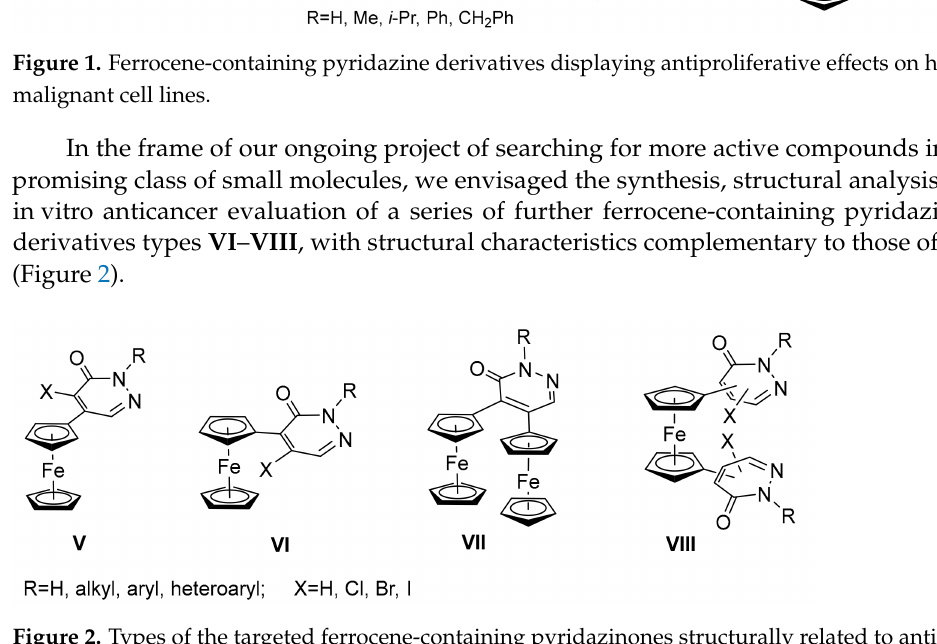
Figure 2. Types of the targeted ferrocene-containing pyridazinones structurally related to antiprolif- erative compounds I – IV (Figure